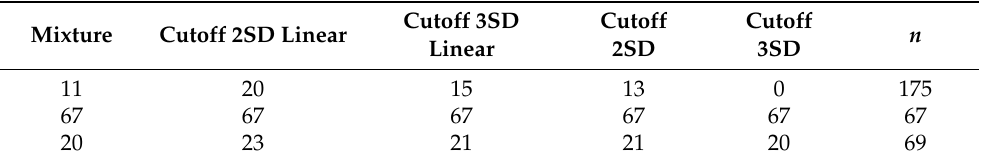
Figure A2. Posterior parameter estimates and prior dependence. The Baseline and alternative scenar- ios are presented in different rows. The shaded priors are uninformative (wide), and the posterior estimates can be seen not to be influenced by the choice of the prior distribution: ( a ) posteriors of µ baseline+ colored by component; ( b ) posteriors of µ shift ; ( c ) posteriors of σ , colored by component; and ( d ) posteriors of p study , colored by study. Table A1. Number of rats scoring positive, for the different cut-offs, and the cut-off implied by setting p pos = 1/2 in the mixture model. The total number of rats is n